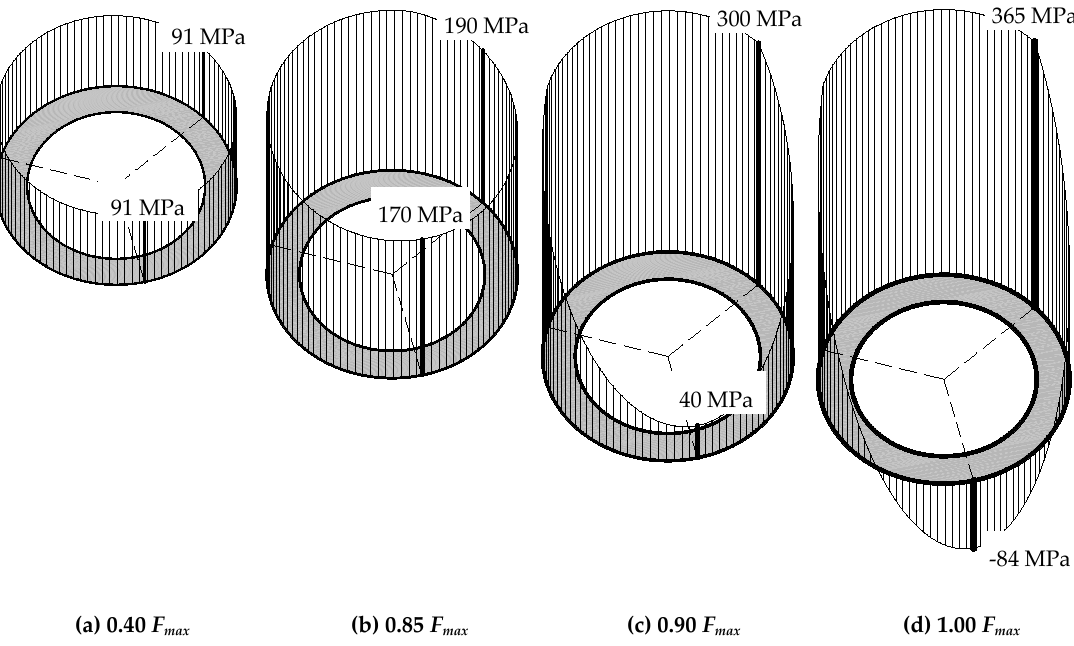
Figure 12. Stress distribution corresponding to the subsequent load levels: ( a ) at 40%, ( b ) at 85%, ( c ) at 90% of the experimental load F max , ( d ) at failure.